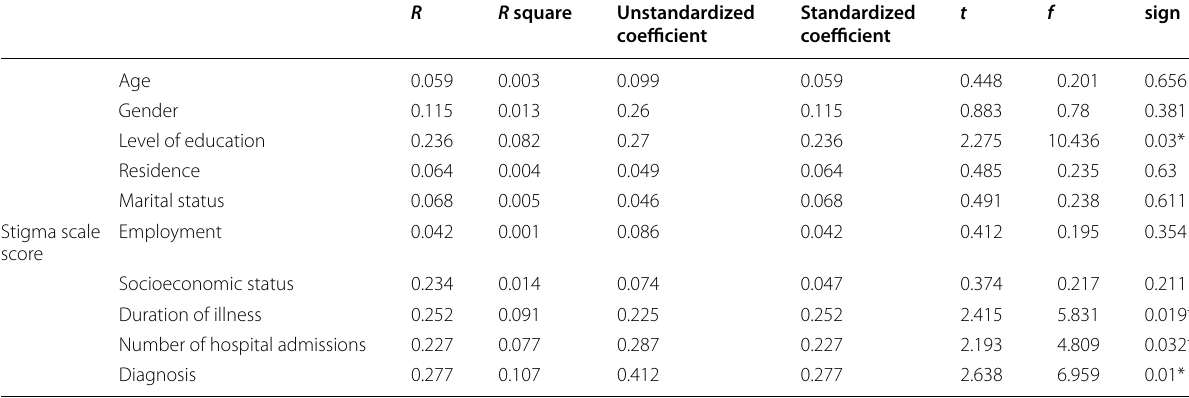
P value < 0.05 is considered statistically significant (*)